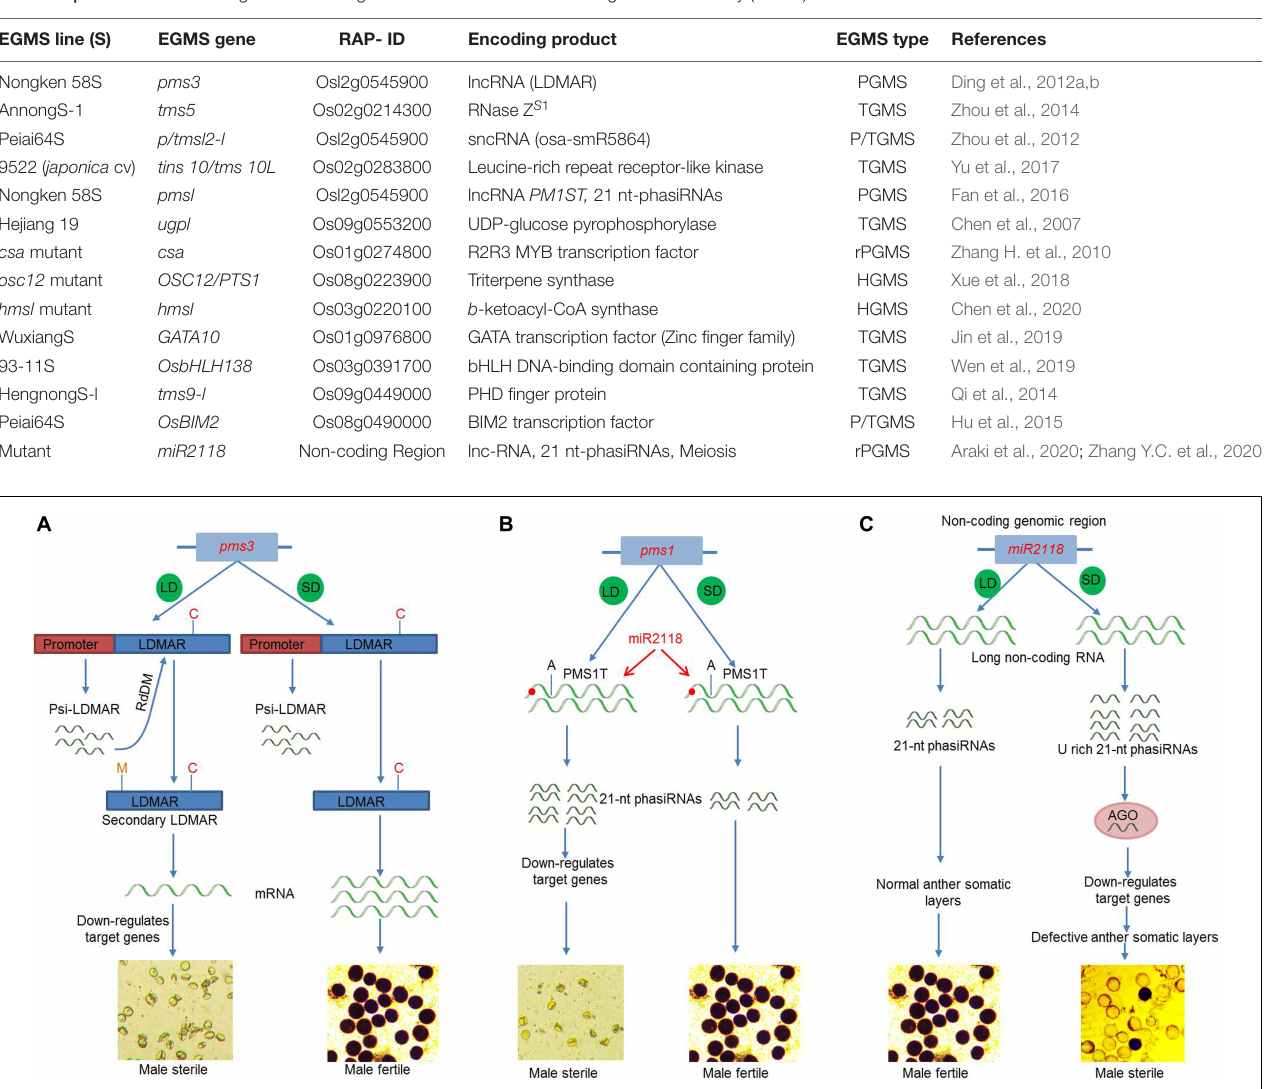
TABLE 2 | List of characterized genes for the regulation of environment-sensitive genic male sterility (EGMS) in rice.